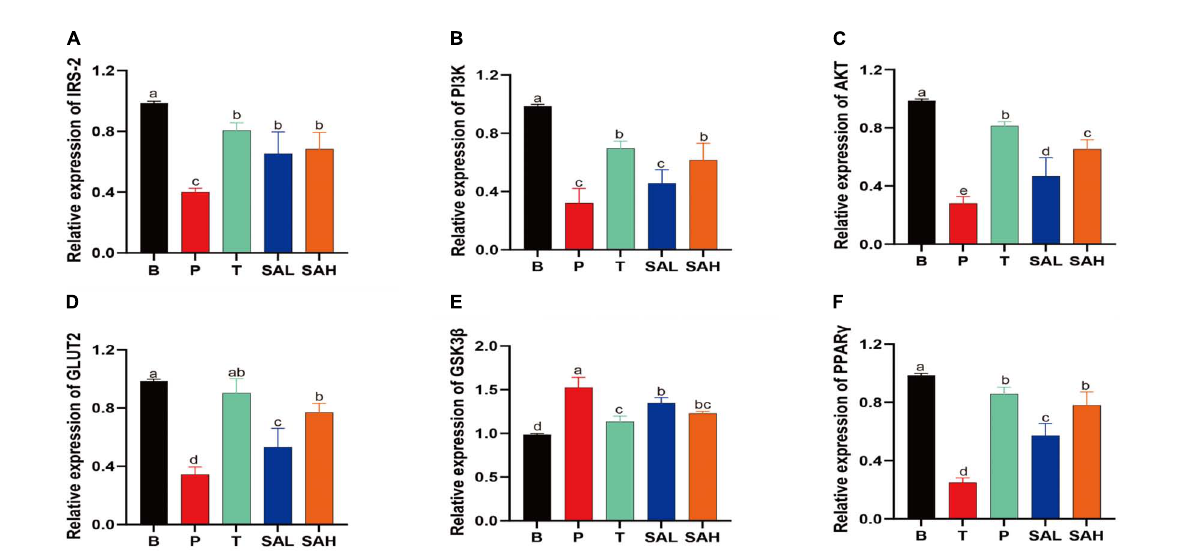
FIGURE4 Sciadonic acid (SA) promotes gluconeogenic gene expression. Data are presented as the mean ± SD of three experiments. (A) IRS-2, (B) PI3K, (C) AKT, (D) GLUT-2, (E) GSK3ß, and (F) PPAR γ . Data are presented as the mean ± SD of three experiments. Different letters represent a significant difference among multiple groups ( P < 0.05). B, control group; P, diabetic model group; T, (HFD + 200 mg kg – 1 Met); SAL, (HFD + 70 mg kg – 1 SA); SAH, (HFD + 280 mg kg – 1